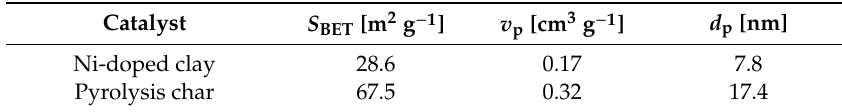
Table 2. Results of N 2 adsorption on Ni-doped (3 mass%) clay mineral [16] and carbonized pyrolysis char